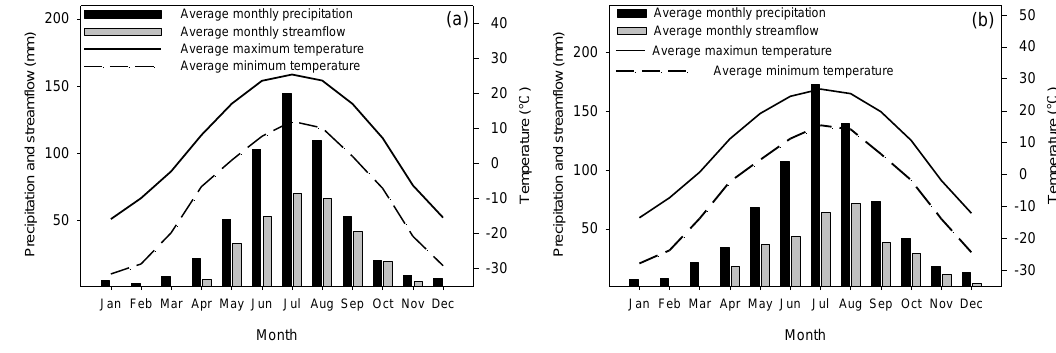
Figure 2. Average monthly streamflow, precipitation, and air temperature in the UTH ( a ) and XNC ( b ) watersheds from 1987 to 2016.